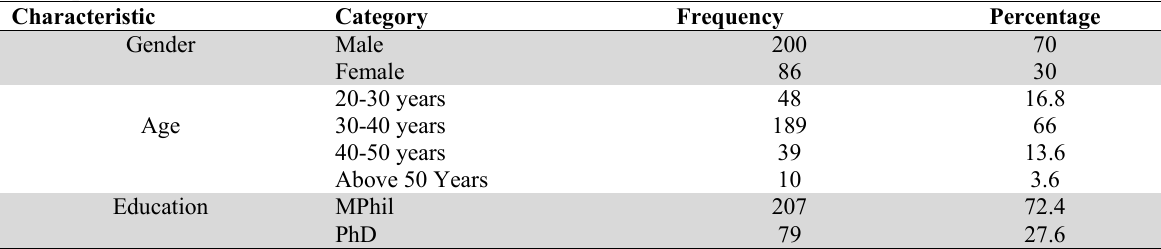
Descriptive Statistics